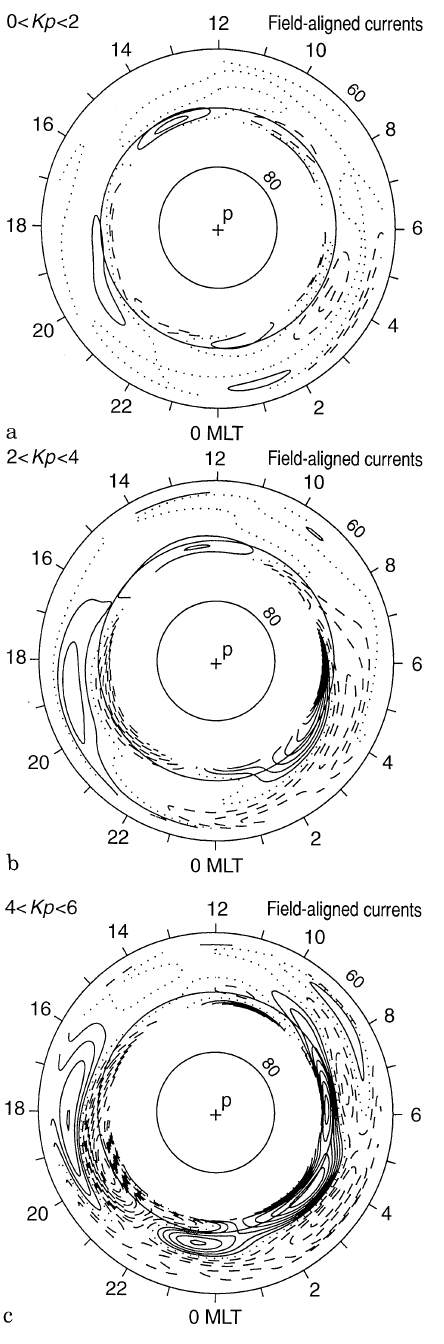
Fig. 4. Polar distribution of field-aligned currents for the three magnetic-activity ranges. Full lines represent downward currents, dashed lines upward currents. The contour threshold and intervals are set to 0.1 (cid:108) A/m (cid:50) (0.075 (cid:108) A/m (cid:50) for Kp " 0 — 2)